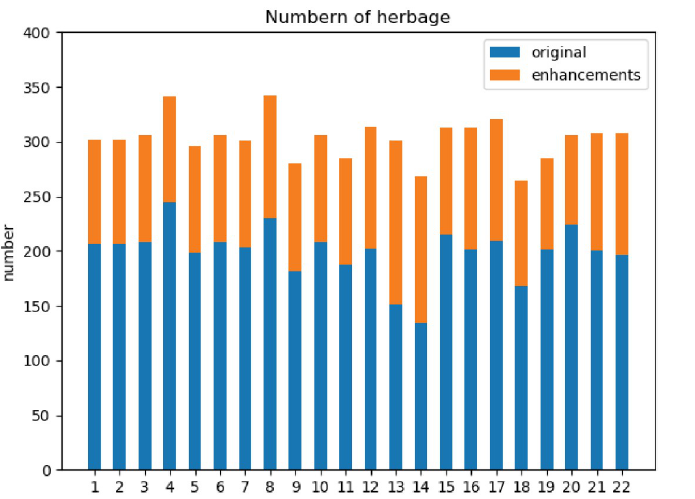
Fig 3. Quantity before and after data balance for each type of forage grasses.